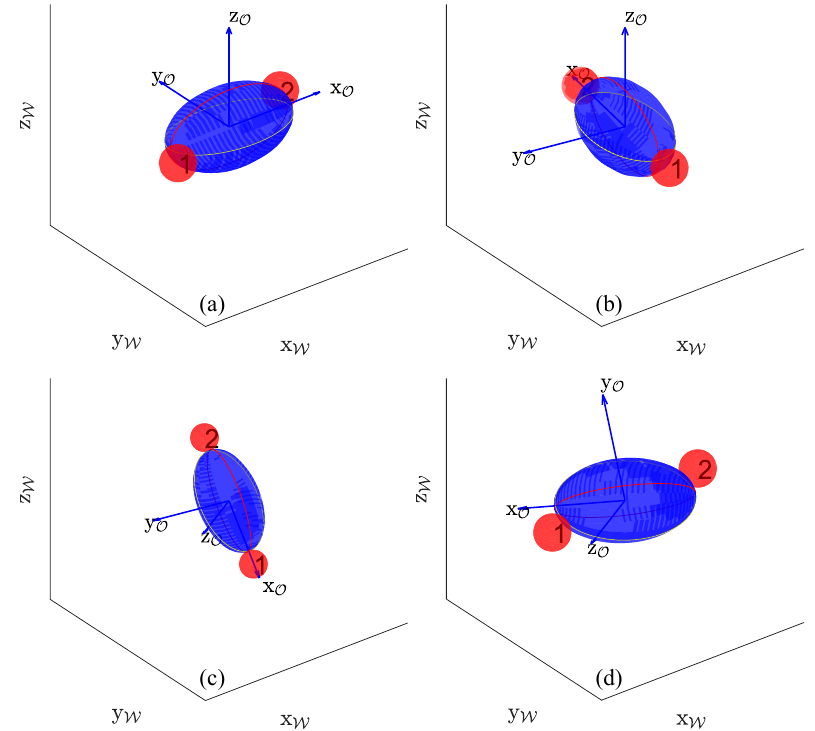
Figure 6. Representation of combined rotations: ( a ) initialization, ( b ) first rotation, ( c ) second rotation, ( d ) third rotation. The first and third rotations are obtained using rolling only without finger gaiting; the trajectory of the second rotation is detailed in Figure